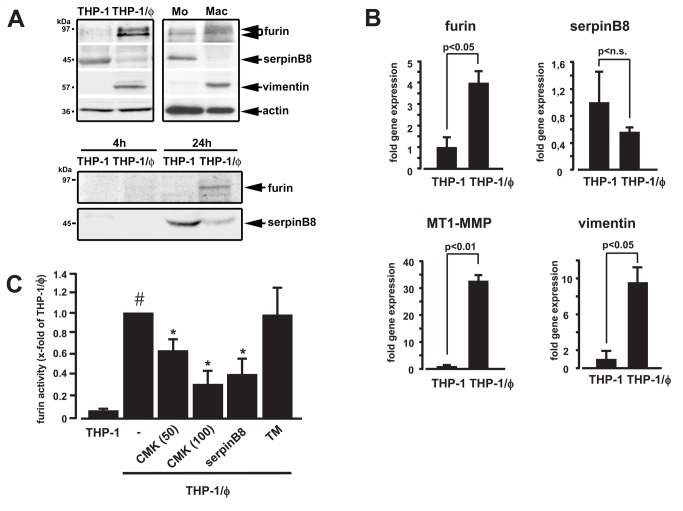
Regulation of furin and serpinB8 during monocyte transformation.(A) Monocyte transformation (THP-1 cells (upper left), primary monocytes (upper right)) to macrophages (THP-1/ϕ) was evident by vimentin expression. Furin was increased and serpinB8 was decreased in macrophages (upper panel). Furin was detected in its pro- and active form (actin-reblotting for protein loading). Immunoblotting of supernatants demonstrated that furin was time-dependently shed from THP-1/ϕ, whereas serpinB8 was primarily released from monocytic cells (both at 24h; lower panel). (B) QRT-PCR demonstrated significant upregulation of furin and MT1-MMP accompanying vimentin in THP-1/ϕ, whereas decreases in serpinB8 were non-significant. (C) Cell-transformation increased furin-like PCSK activity (#p<0.05 THP-1/ϕ vs. THP-1 cells), which was concentration-dependently inhibited by dec-CMK (CMK, 50 and 100 µmol/L; 12h), or transfection of THP-1/ϕ with serpinB8 protein (5 µg/mL; 12h). TM = transfection medium. *p<0.05 vs. THP-1/ϕ. n=3.